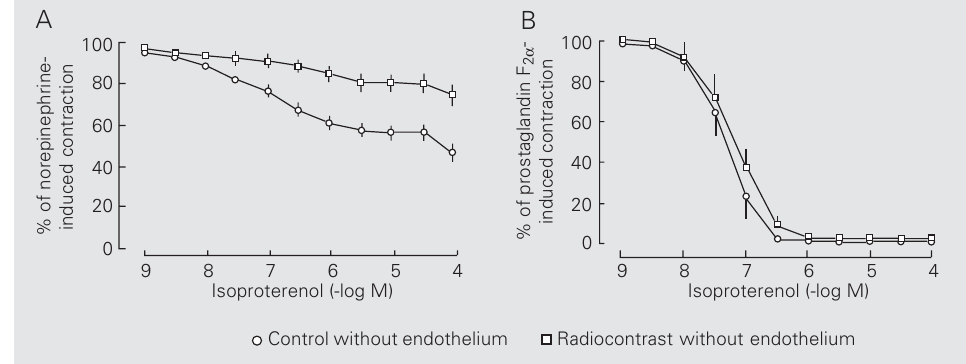
Figure 2. Relaxation in response to isoproterenol by the canine renal artery. Canine renal arteries were exposed to ionic radiocontrast (1 ml per 25 ml of Krebs solution) and contracted with norepinephrine or prostaglandin F 2 α . When the contraction was stable, arteries were exposed to increasing concentrations of isoproterenol. A , Canine renal arteries exposed to ionic radiocontrast and contracted with norepinephrine. (N = 6); B , Canine renal arteries exposed to ionic radiocontrast and contracted with prostaglandin F 2 α (N = 6). Data are reported as means ± SEM.